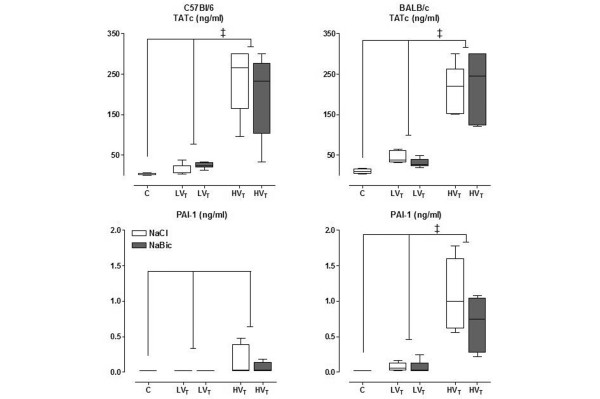
Thrombin-antithrombin complexes (TATc) levels and plasminogen activator inhibitor (PAI)-1 levels in bronchoalveolar lavage fluid. TATc levels and PAI-1 levels in bronchoalveolar lavage fluid in control mice, and in mice ventilated with low tidal volumes (LVT) and high VT(HVT) for five hours. Two fluid strategies (normal saline (white boxes) and sodium bicarbonate (grey boxes)) were compared. Data represent median and interquartile range of six mice. ‡p < 0.001 (HVT vs. LVT).